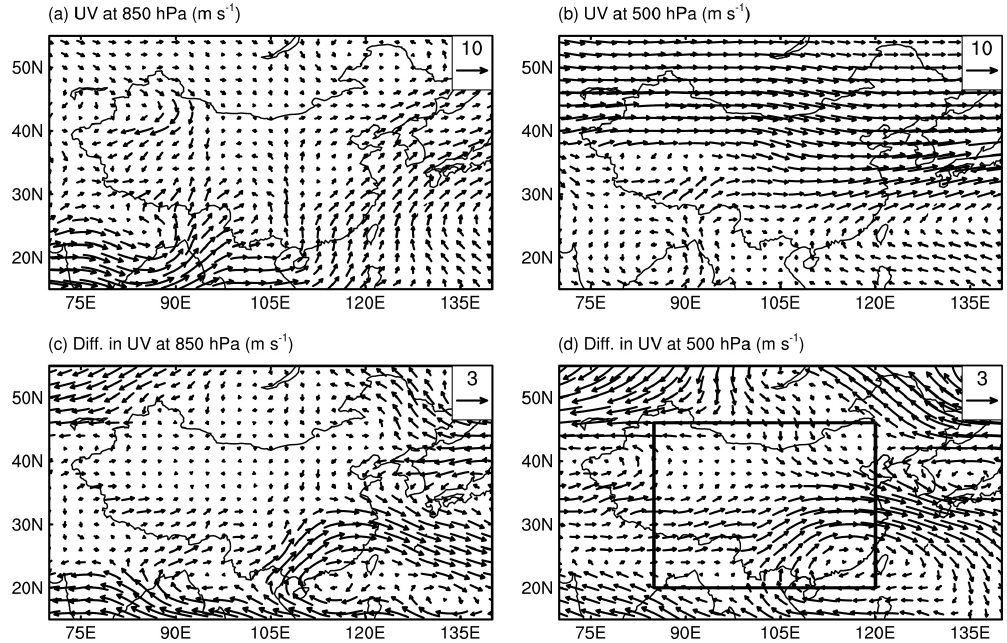
Figure 5. The JJA mean horizontal winds at (a) 850 and (b) 500hPa averaged over years 1986–2006. The composite differences in horizontal winds between the five weakest and strongest EASM years (weakest–strongest) at (c) 850 and (d) 500hPa. Horizontal winds are from the GEOS-4 assimilated meteorological data. Unit is shown on top of each panel. The location of box (85–120 ◦ E, 20–46 ◦ N, the surface to 250hPa) selected to capture the features of transboundary O 3 transport is also shown in (d) .